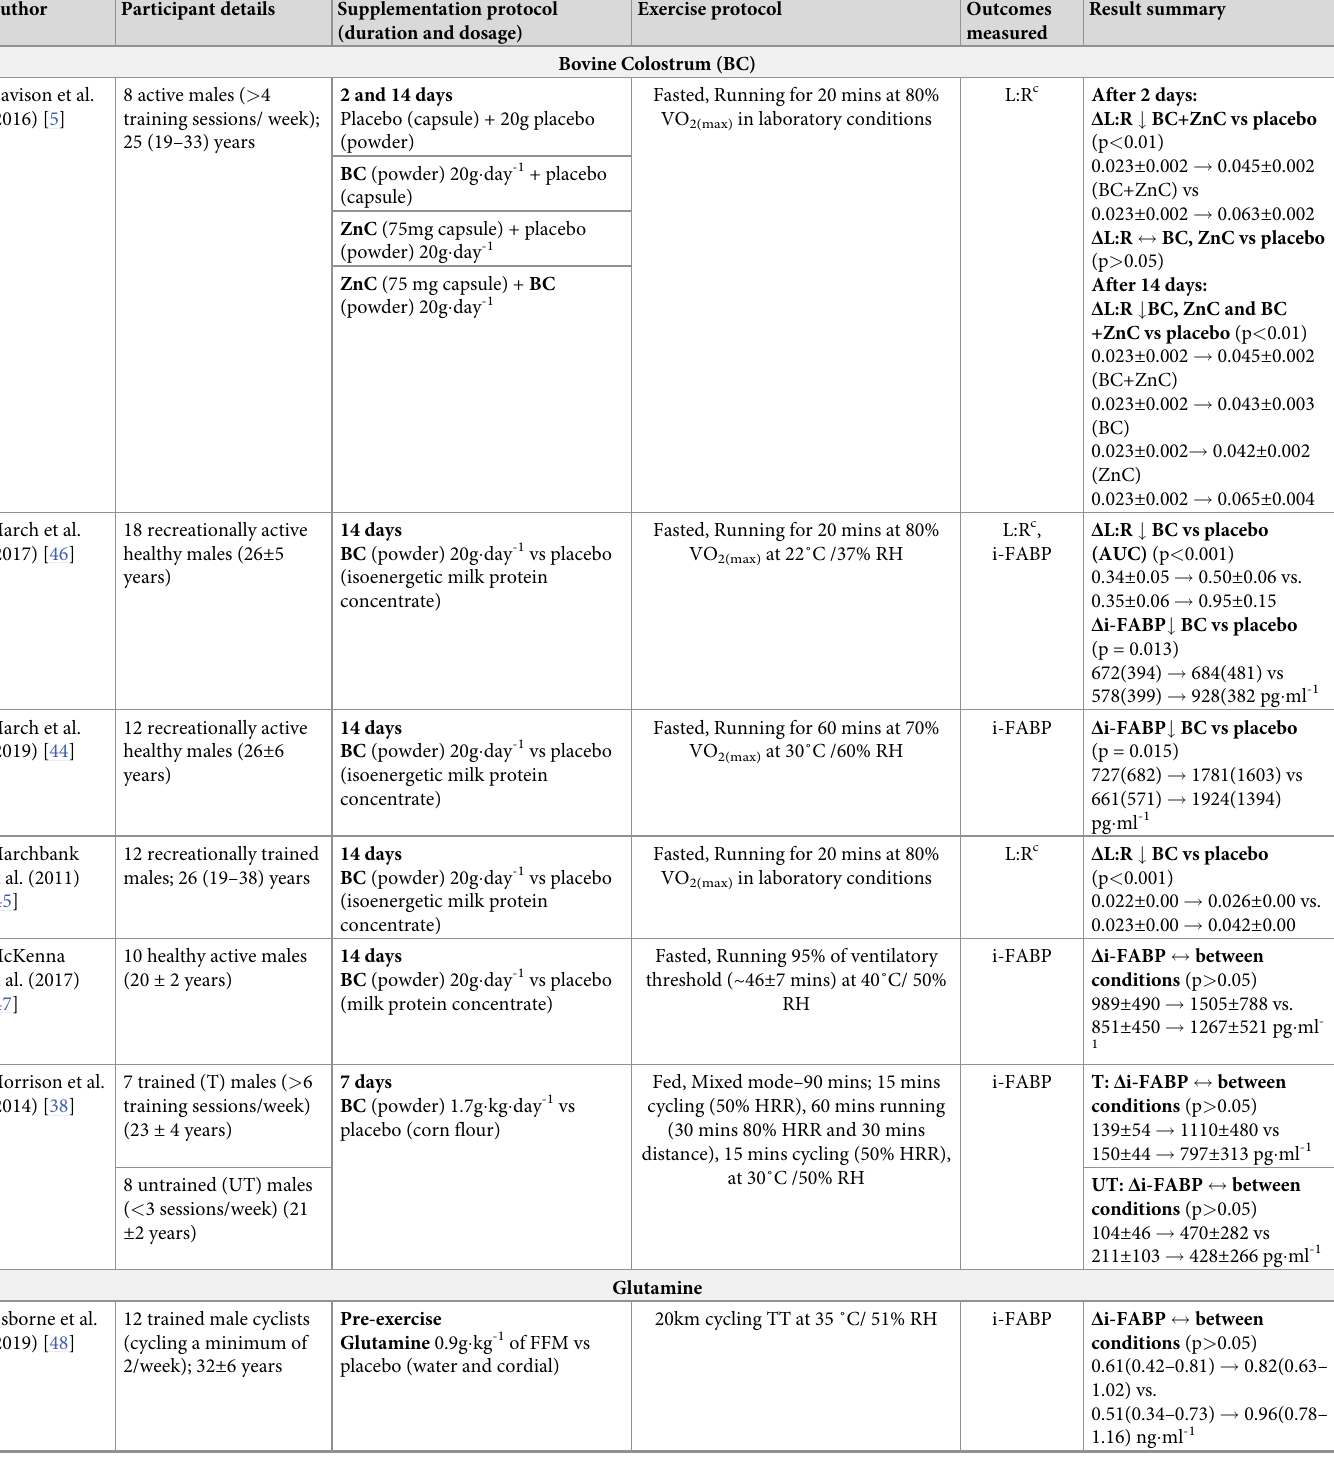
Table 1. Summary data from studies investigating the impact of specific supplements on markers of gut cell damage and